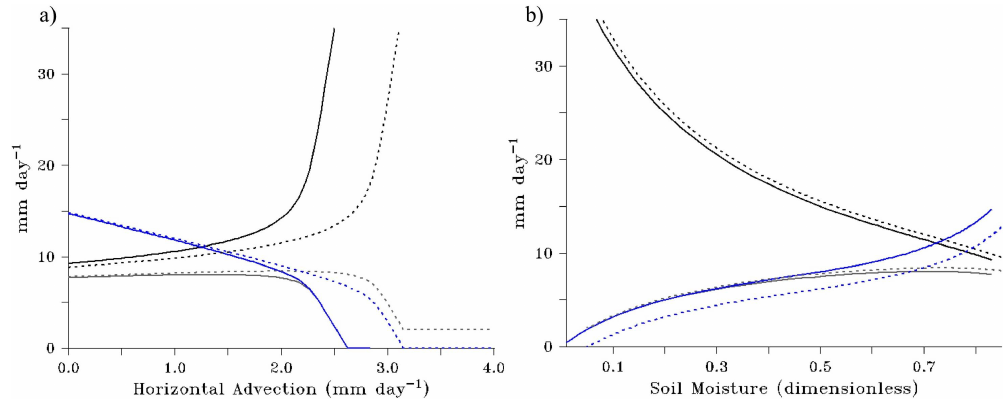
Figure 9. Large-scale irrigation impacts on prototype hydroclimate. (a) E p (black), E (gray), and P (blue) for the baseline (solid curves) and I = 2mmday − 1 large-scale irrigation scenario (dotted curves), plotted with respect to horizontal moisture advection, scaled to units of mmday − 1 . Here, horizontal advection values correspond to drying advection, which are associated with decreasing precipitation. (b) As in (a) but with soil moisture as the